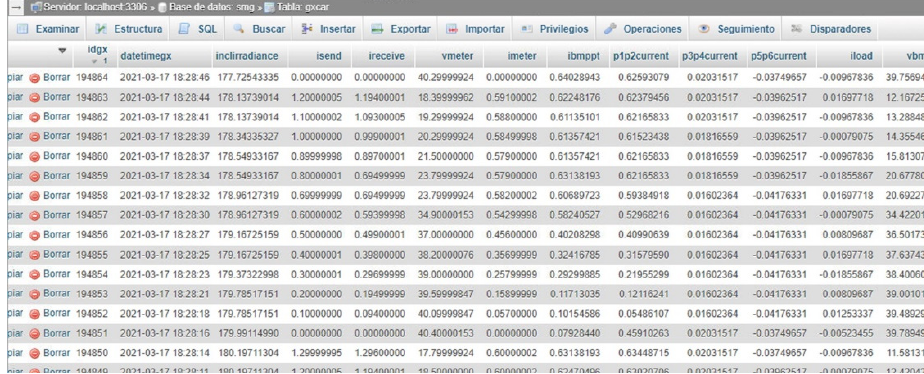
Figure 7. Python code for I ‐ V curve tracing. Algorithm 1 RS232 communication through Python